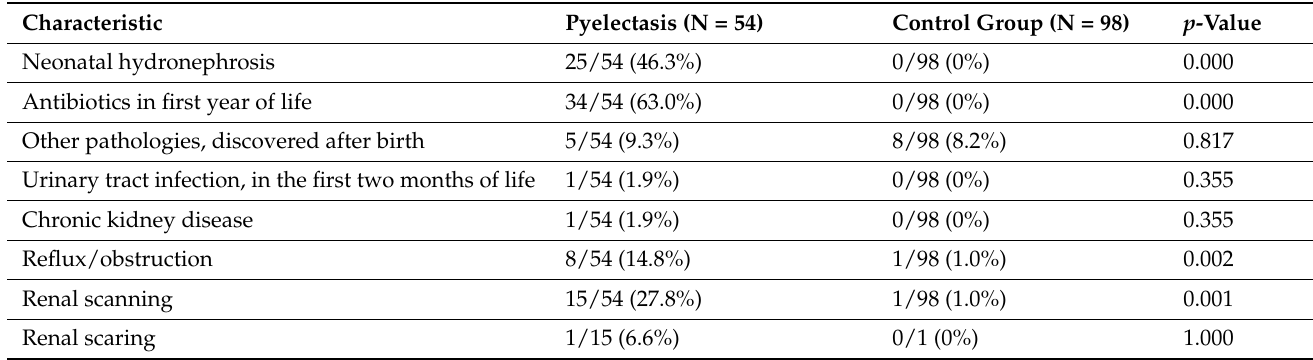
Table 3. Sequalae of children with pyelectasis vs. control